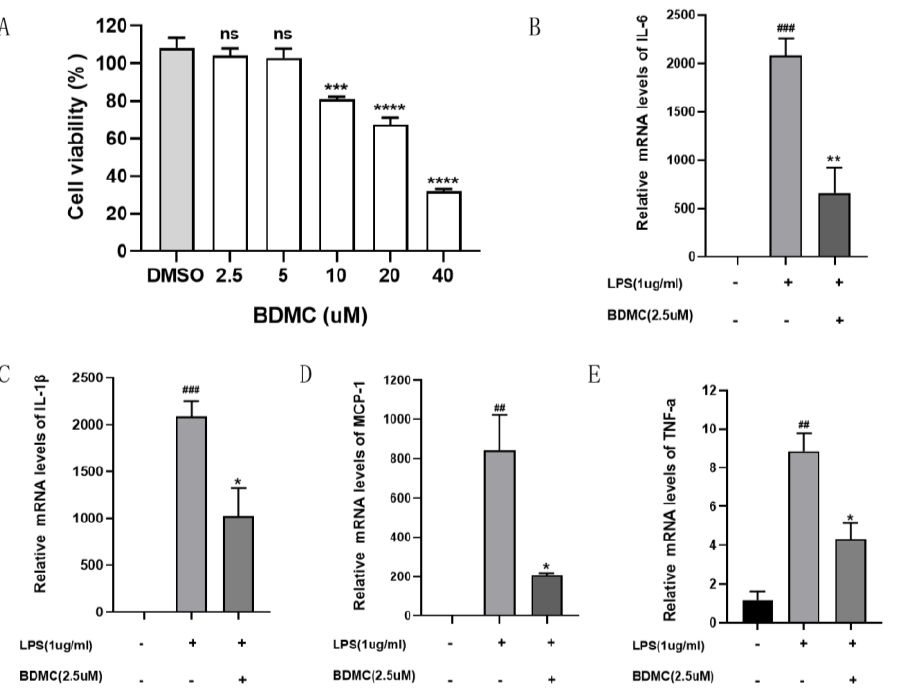
Figure 6. ( A ) BDMC as indicated. Cell viability was determined by CCK8 assays. Data are presented as the mean ± SEM. *** p < 0.001, **** p < 0.0001 vs. vehicle control (DMSO). BDMC decreases the levels of proinflammatory factors ( B − E ). RAW264.7 cells were pre-treated for 1 h with 2.5 uM concentrations of bisdemethoxycurcumin and incubated with or without LPS (1 μ g/mL) for 24 h. The expressions of IL − 6 ( B ), IL −1β ( C ), MCP − 1 ( D ), and TNF − a mRNA levels were examined by real-time PCR. Data are presented as the mean ± SEM. ## p < 0.01; ### p < 0.001 vs. control group; * p < 0.05; ** p < 0.01; *** p < 0.001; **** p <0.0001 vs. LPS group.